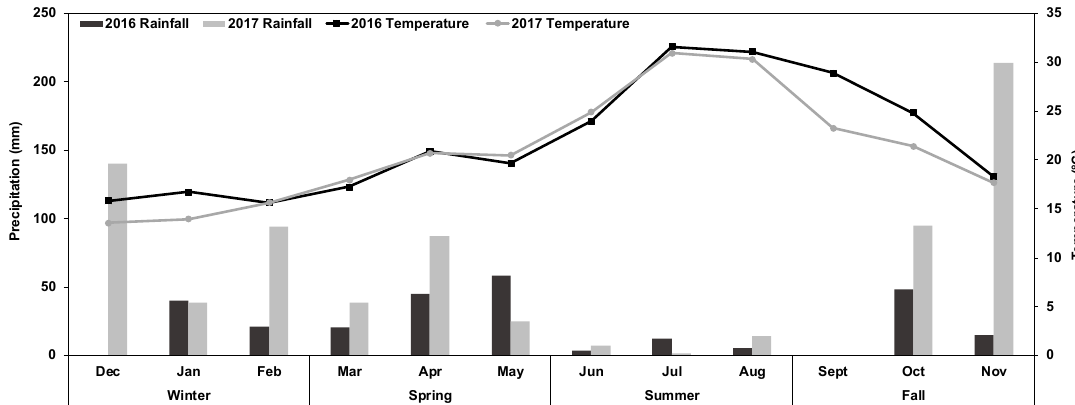
Figure 1. Monthly mean of air temperature (°C) and precipitation (mm) of 2016 and 2017 in Chefchaouen (Northern Morocco). Data source: DRATT [10].